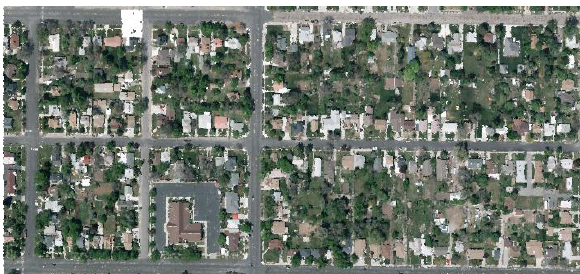
Figure 7. The testing data which is coloured by RGB